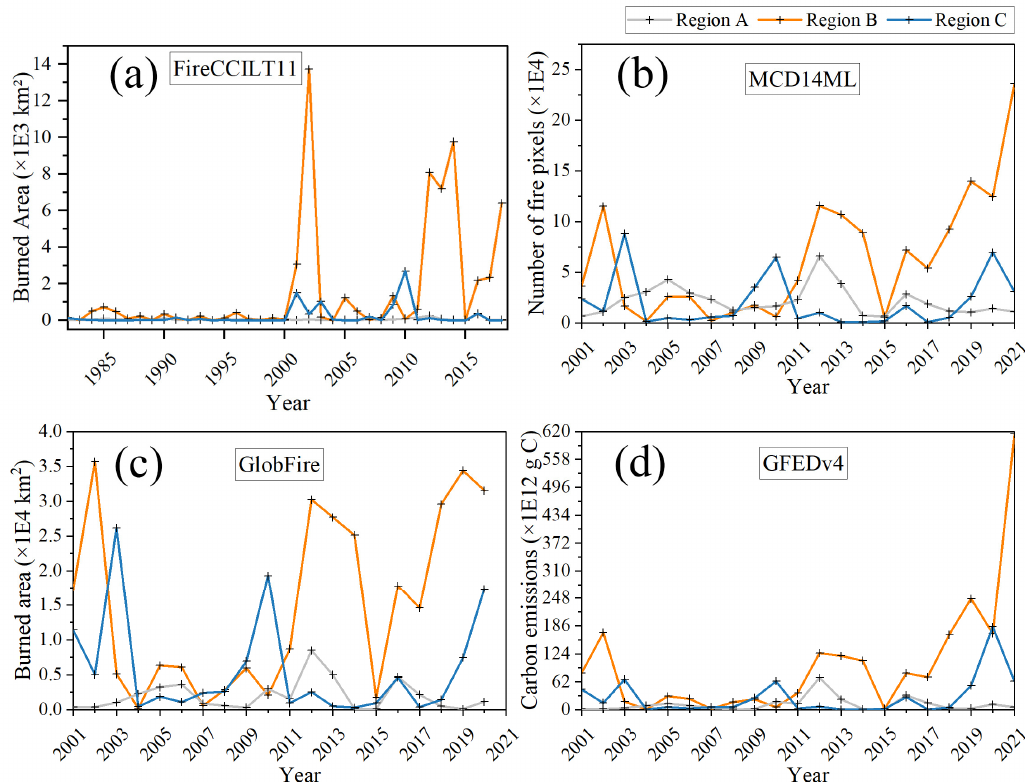
Figure 6. Temporal trends of fires based on number of fire pixels, burnt area, and biomass burning carbon emissions in the three regions of the Eurasian Subarctic. ( a ) Annual burnt area from 1982 to 2018. ( b ) Annual number of MODIS fire pixels from 2001 to 2021. ( c ) Annual burnt area from 2001 to 2020. ( d ) Annual carbon emissions from burning from 2001 to 2021.